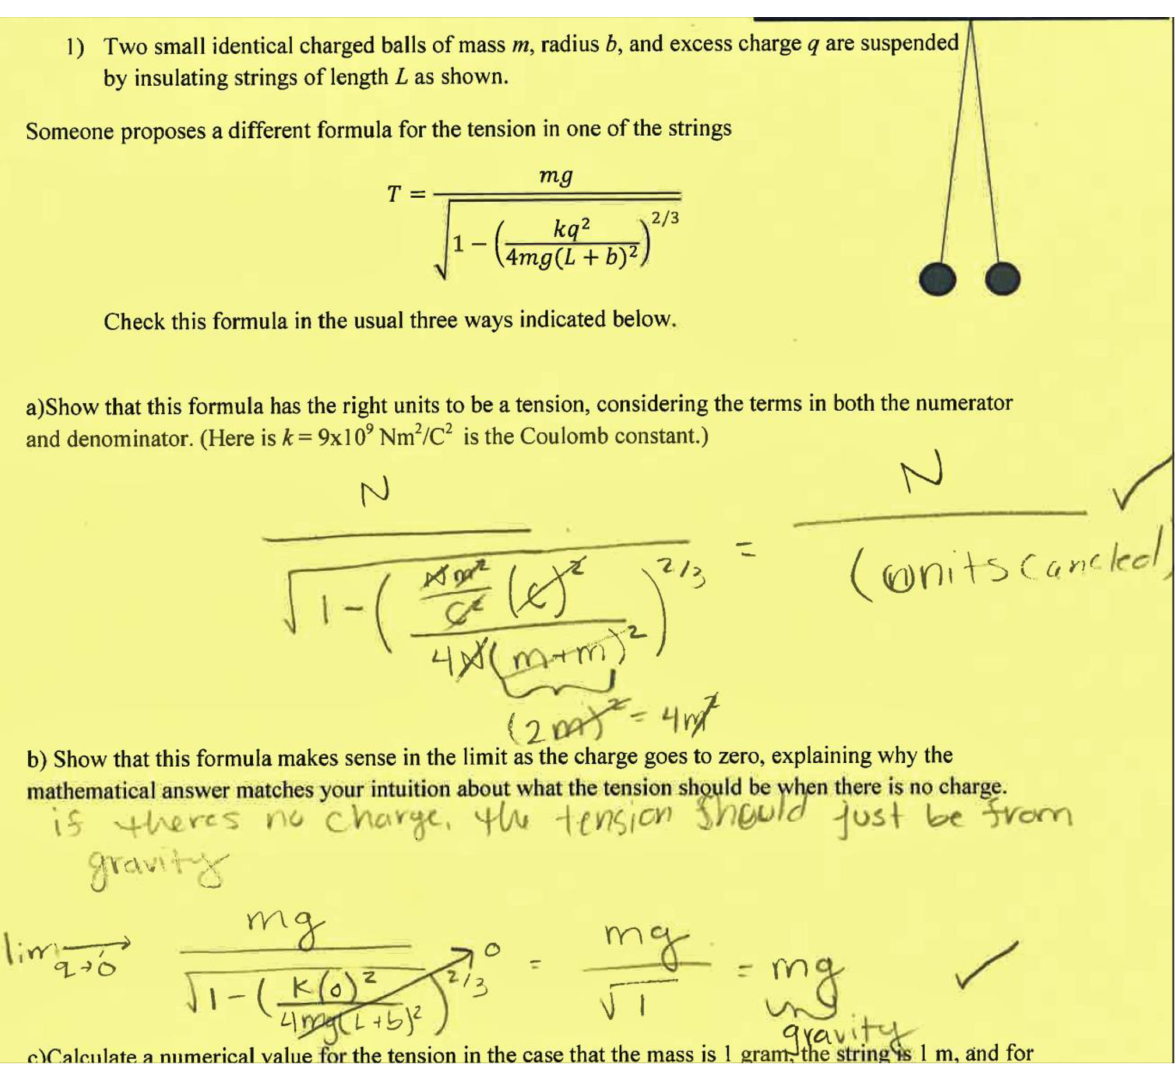
FIG. 6. Student responses to the first LCA prompt provided during year 2 of the study. The prompts provide explicit instructions about which checks to